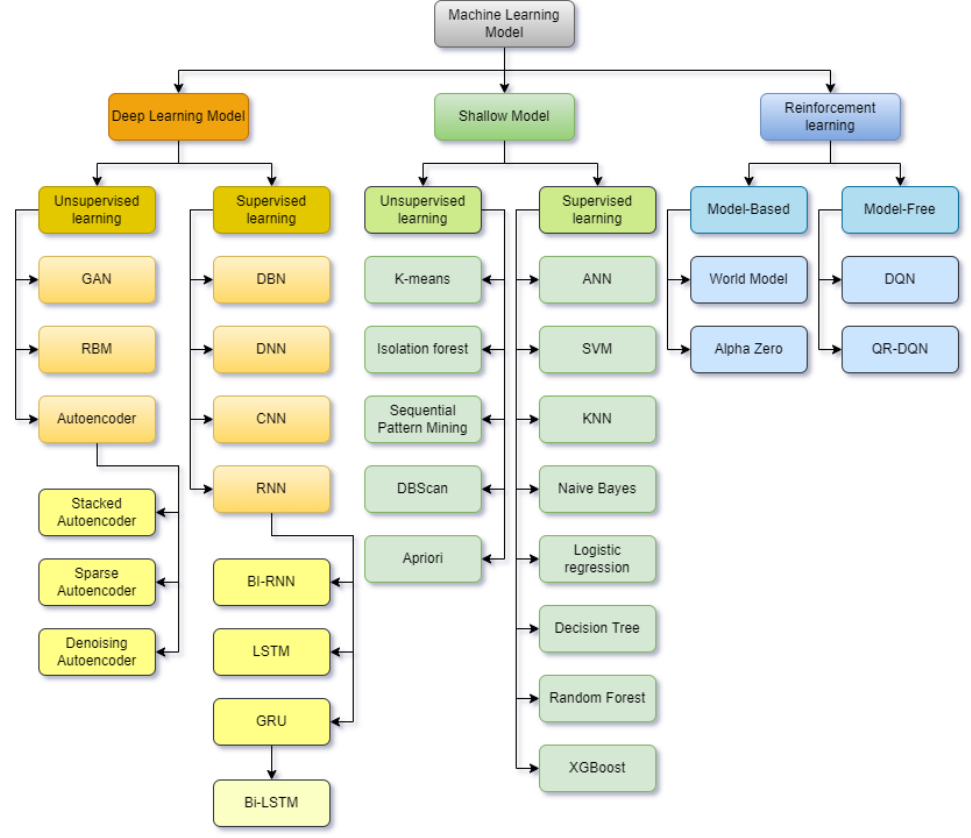
Figure 4. Taxonomy of machine learning